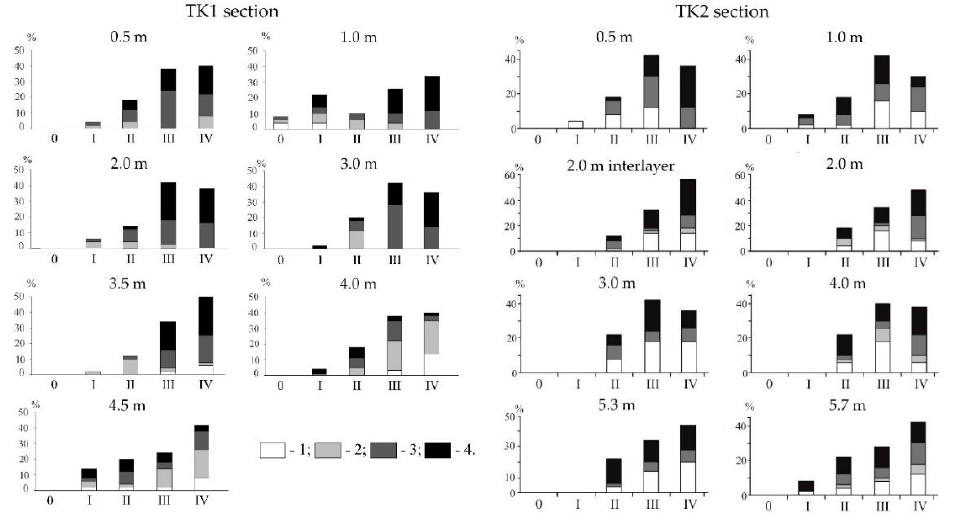
Figure 6. Distribution of quartz sand-grains from sections TK1 and TK2 according to roundness and dullness, where (1) is glossy, (2) is quarter matted (slightly dulled), (3) is half matted (medium dulled), (4) is matted; 0, I, II, III, IV are grades of roundness according to the scale of Khabakov [76].